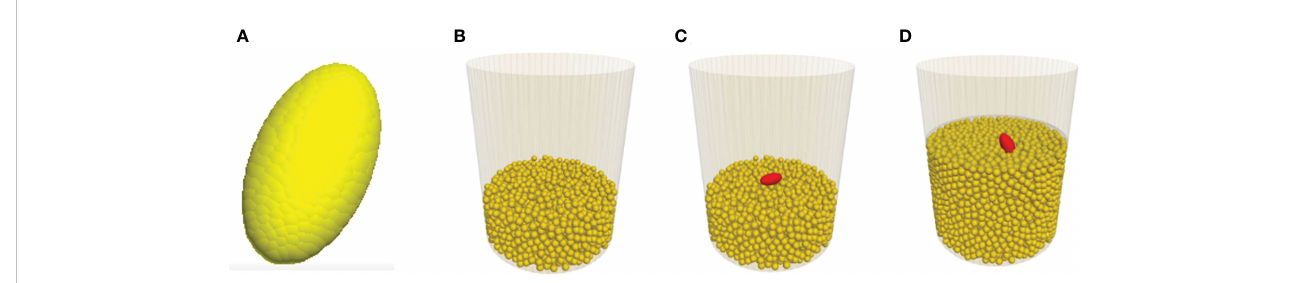
FIGURE 4 Screenshots showing various stages of the modelling. (A) Model cotyledon. (B) Medium particles as the seedbed. (C) Initial position of cotyledon before being covered with medium particles. (D) After being covered, cotyledon emerged from the